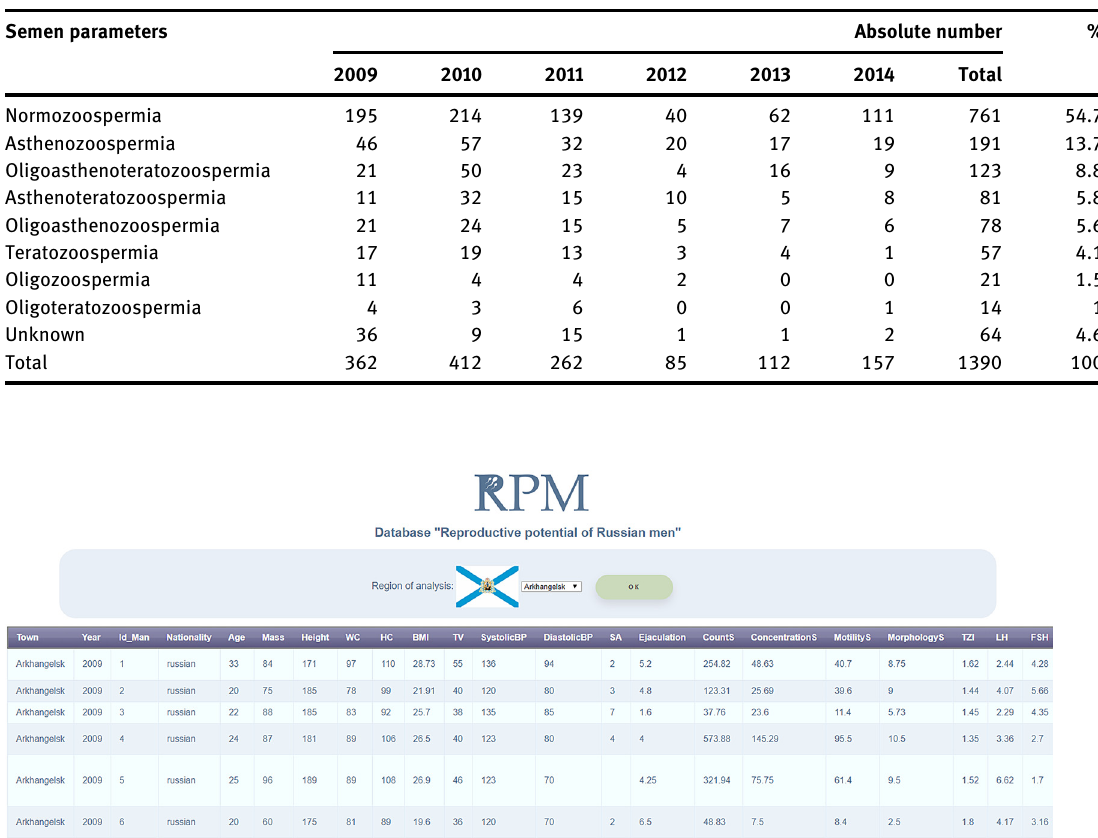
Table  : Distribution of men according to their semen characteristics in the period  –  in the European North and Siberian regions of Russia.